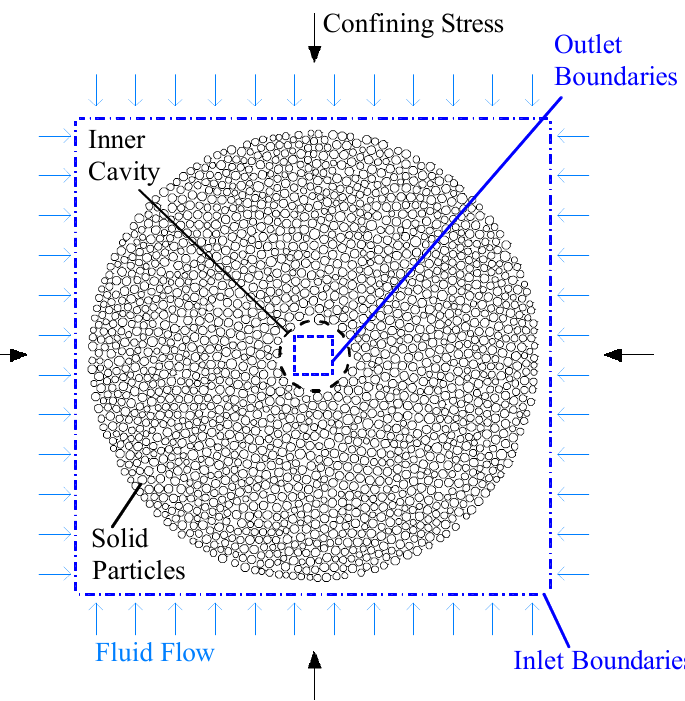
Figure 10. Scheme of model geometry, loading conditions, and fluid flow boundaries of sand production tests.